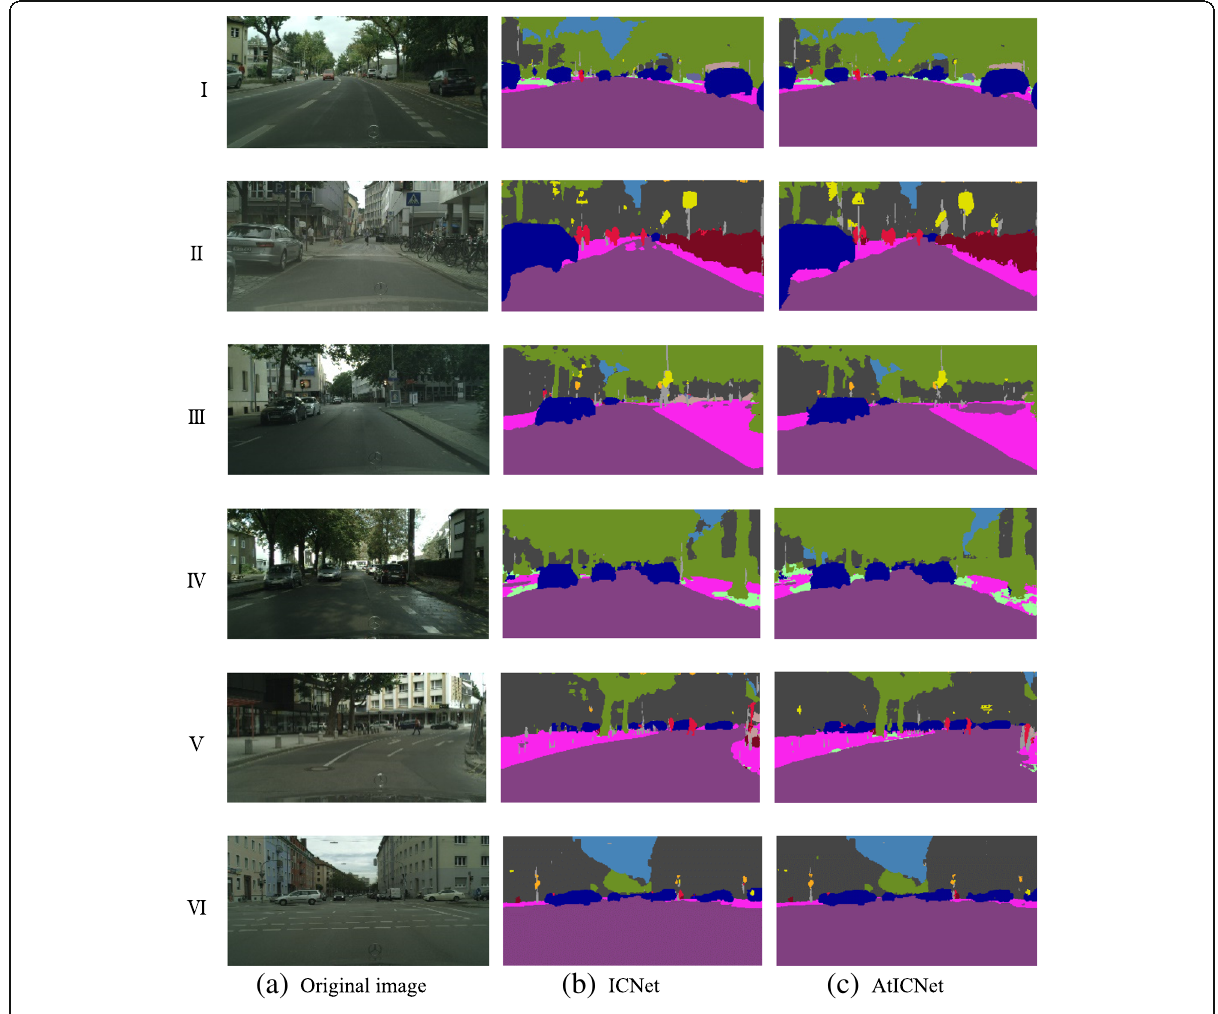
Fig. 4 Comparison of ICNet and AtICNet results. a Original image. b ICNet. c